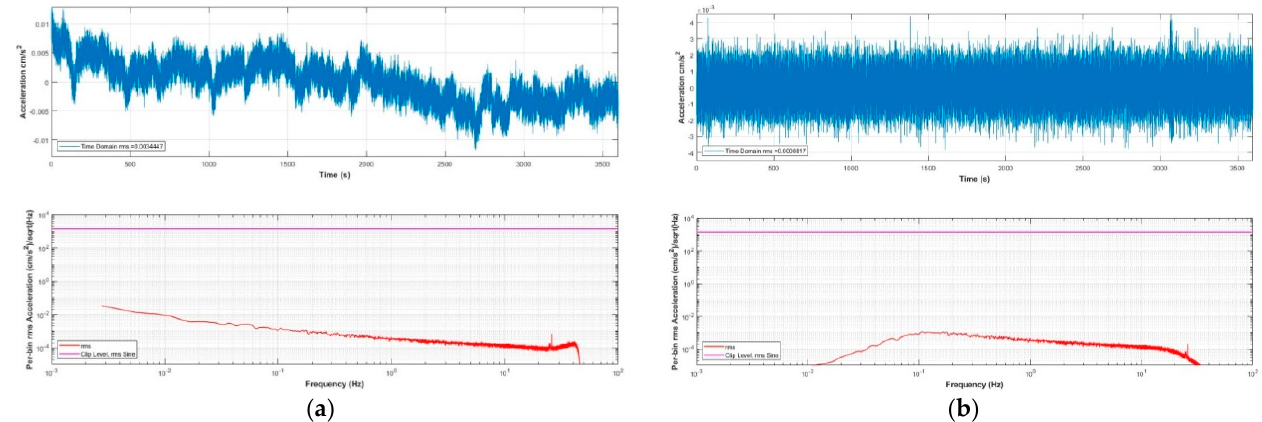
Figure 9. BL-03 force-balance accelerometer recording noise, sampling rate of 100 Hz. ( a ) Unfiltered data; ( b ) data filtered by 0.1–20 Hz bandpass. Table 1. Amplitude–frequency data from our instrument recorded during a session on a jolt table (sampling rate: 200 SPS). Test frequency (Hz)